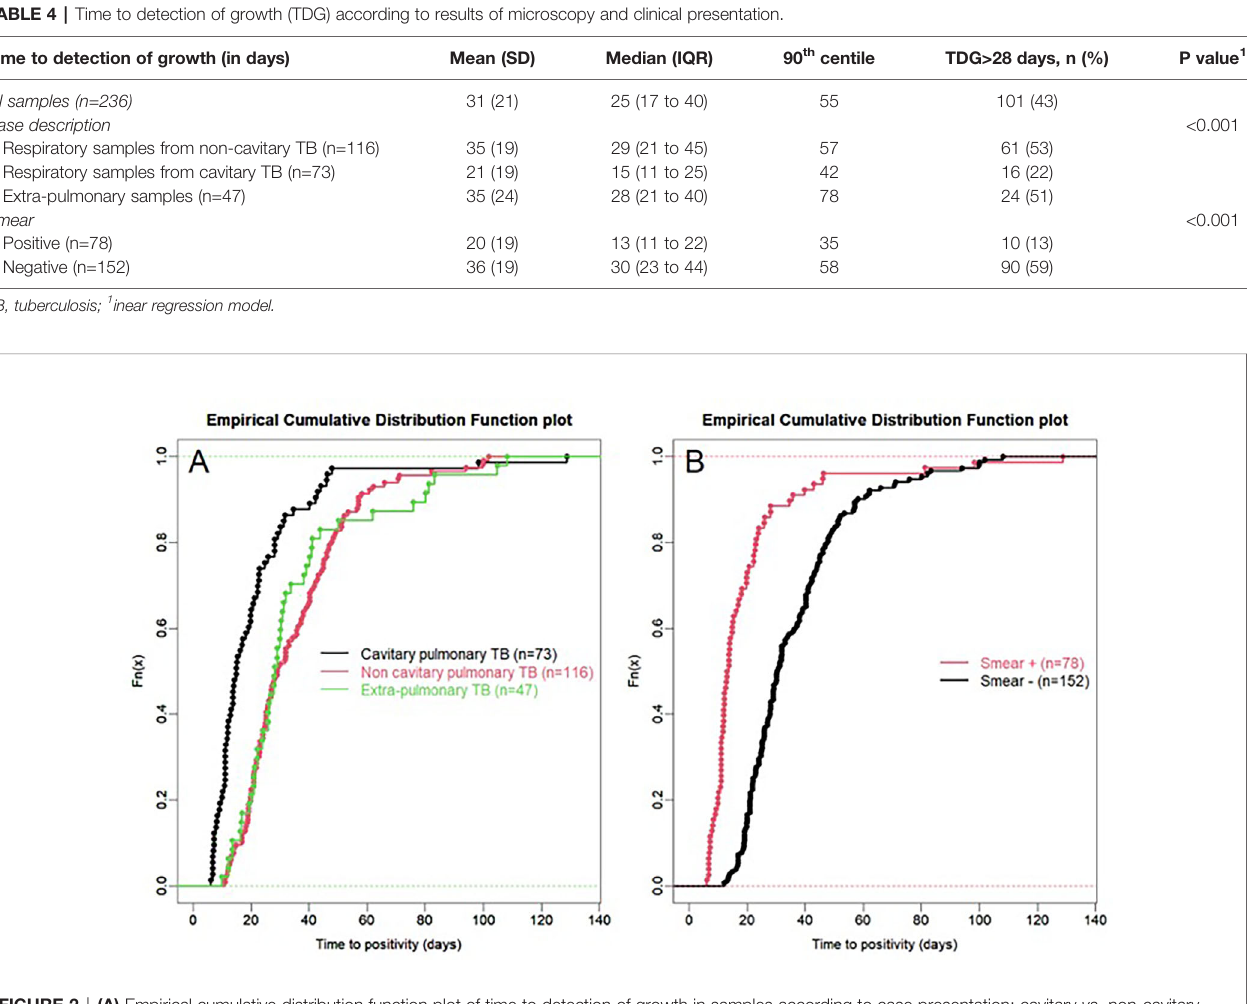
FIGURE 2 | (A) Empirical cumulative distribution function plot of time to detection of growth in samples according to case presentation: cavitary vs. non-cavitary pulmonary tuberculosis vs. extra-pulmonary tuberculosis. (B) Empirical cumulative distribution function plot of time to detection of growth in samples according to microscopy (positive i.e. presence of acid-fast bacilli (AFB), vs negative: absence of AFB) irrespective of case presentation. All samples are PCR